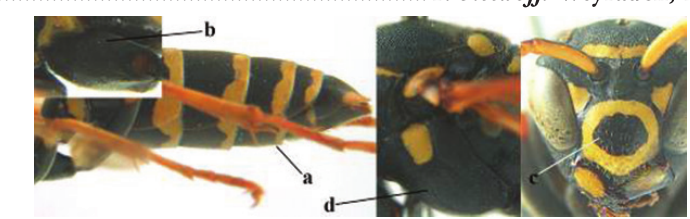
19 Apical yellow band of sternite IV medially interrupted (a) or narrow; hind coxa black dorsally (b); clypeus often with a wide black transverse band or with more or less transverse trapezoid black patch, often close to or con- nected with lateral margins of clypeus and situated nearly halfway clypeus (c); change in sculpture between mesepisternum and epicnemium frequently gradual (d; = epicnemial ridge indistinct); southern C and S Europe............. ........................................................................ P. bischoffi Weyrauch, 1937